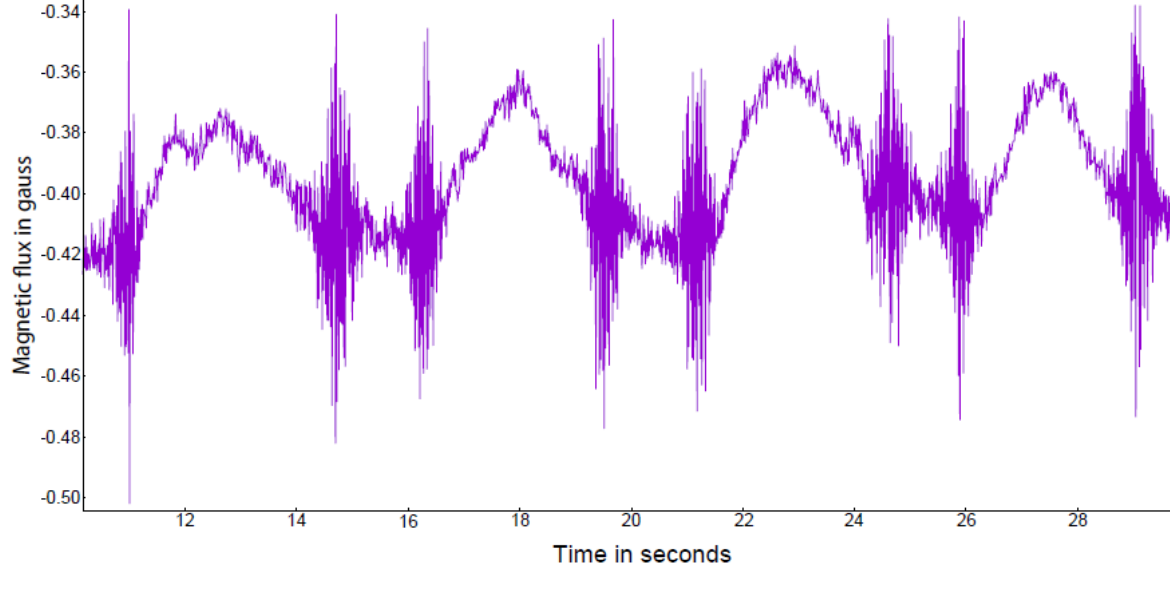
Magnetometer-generated Data While Moving the Sensor Tag Back and Forth Through the RFID Reader Coil